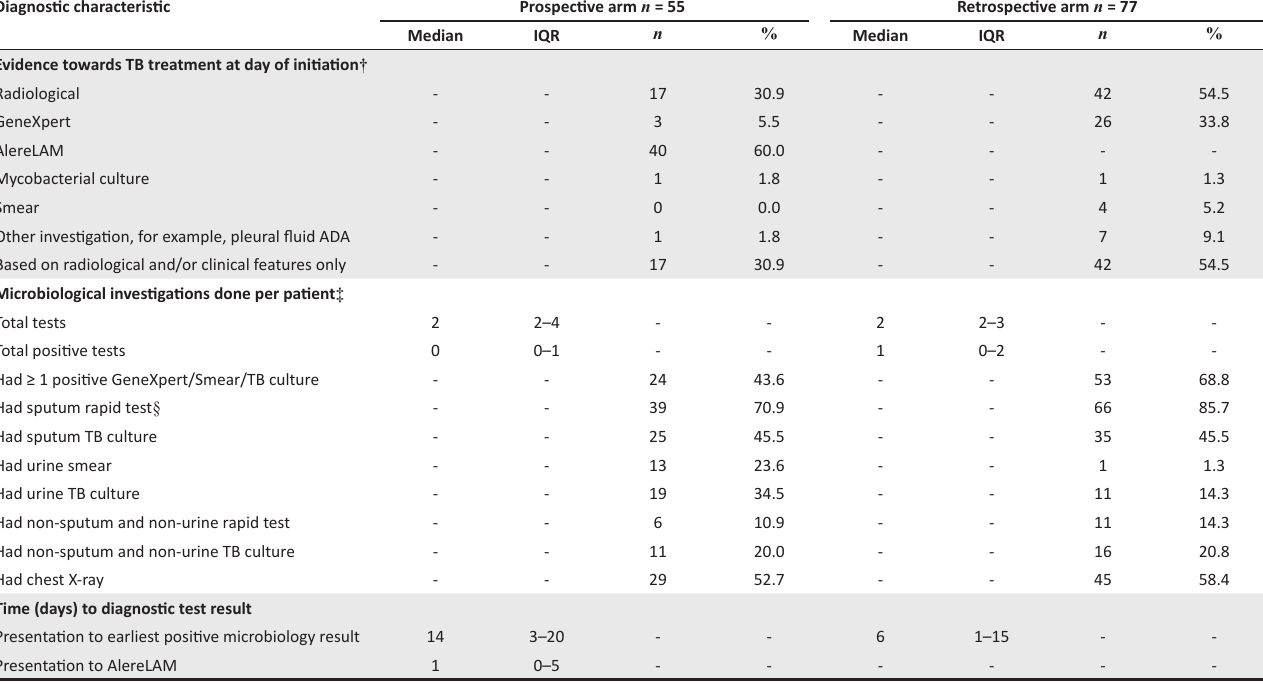
TABLE 2: Tuberculosis diagnostic tests done before and after the introduction of AlereLAM in the primary comparison groups. Diagnostic